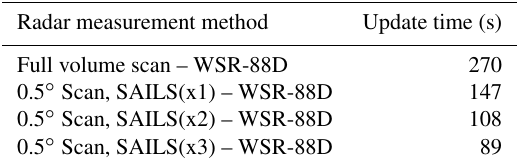
Table 2. Average minimum wait time between low-inclination up- date scans for varieties of WSR-88D scanning